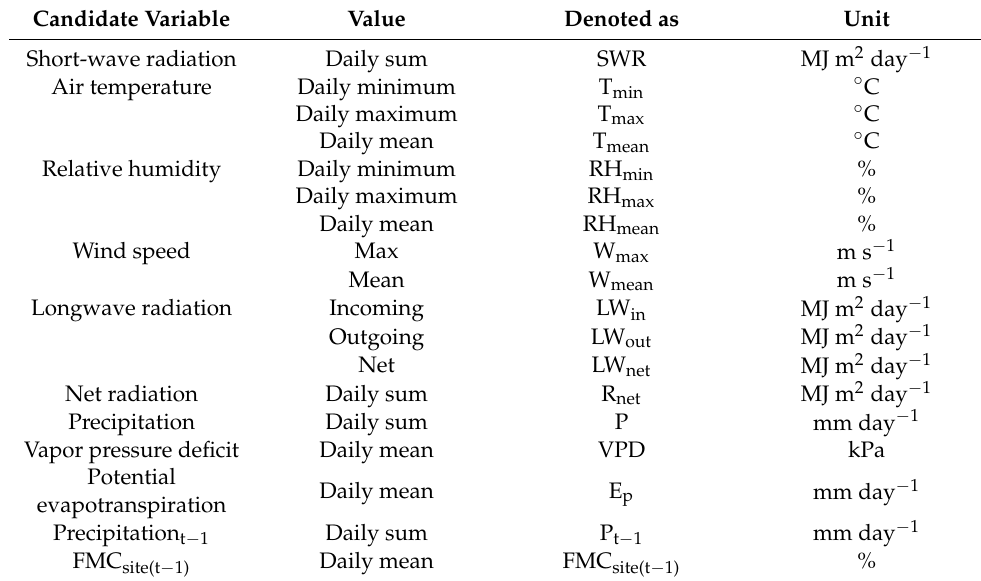
Table 3. Candidate open-weather input variables used in generating the